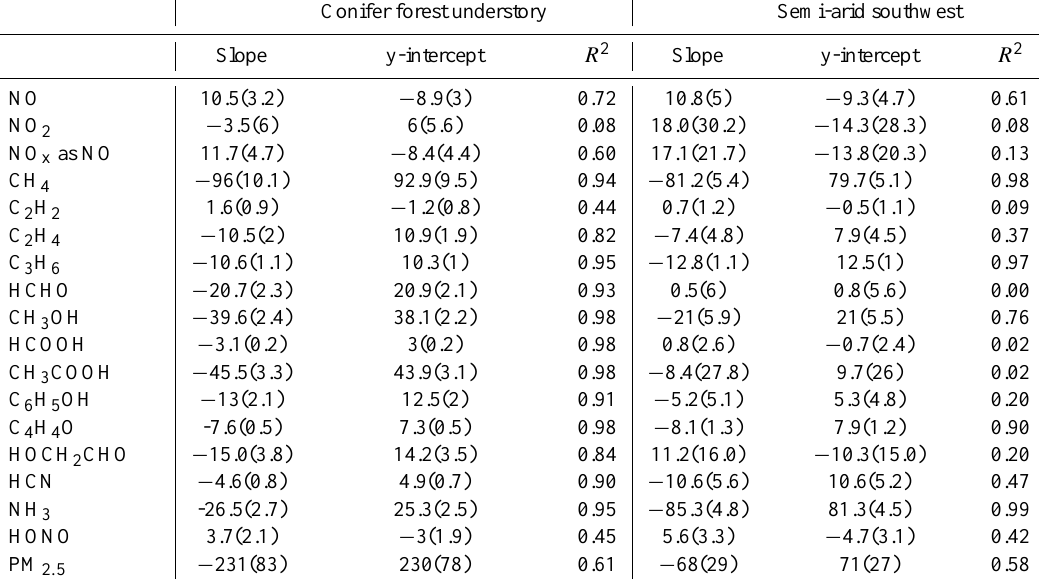
Table 4. Statistics for the linear regression of EF as a function of MCE for conifer forest understory burns and the semi-arid burns of the southwest (chaparral and oak savanna). Values in parentheses represent one standard deviation (1 σ